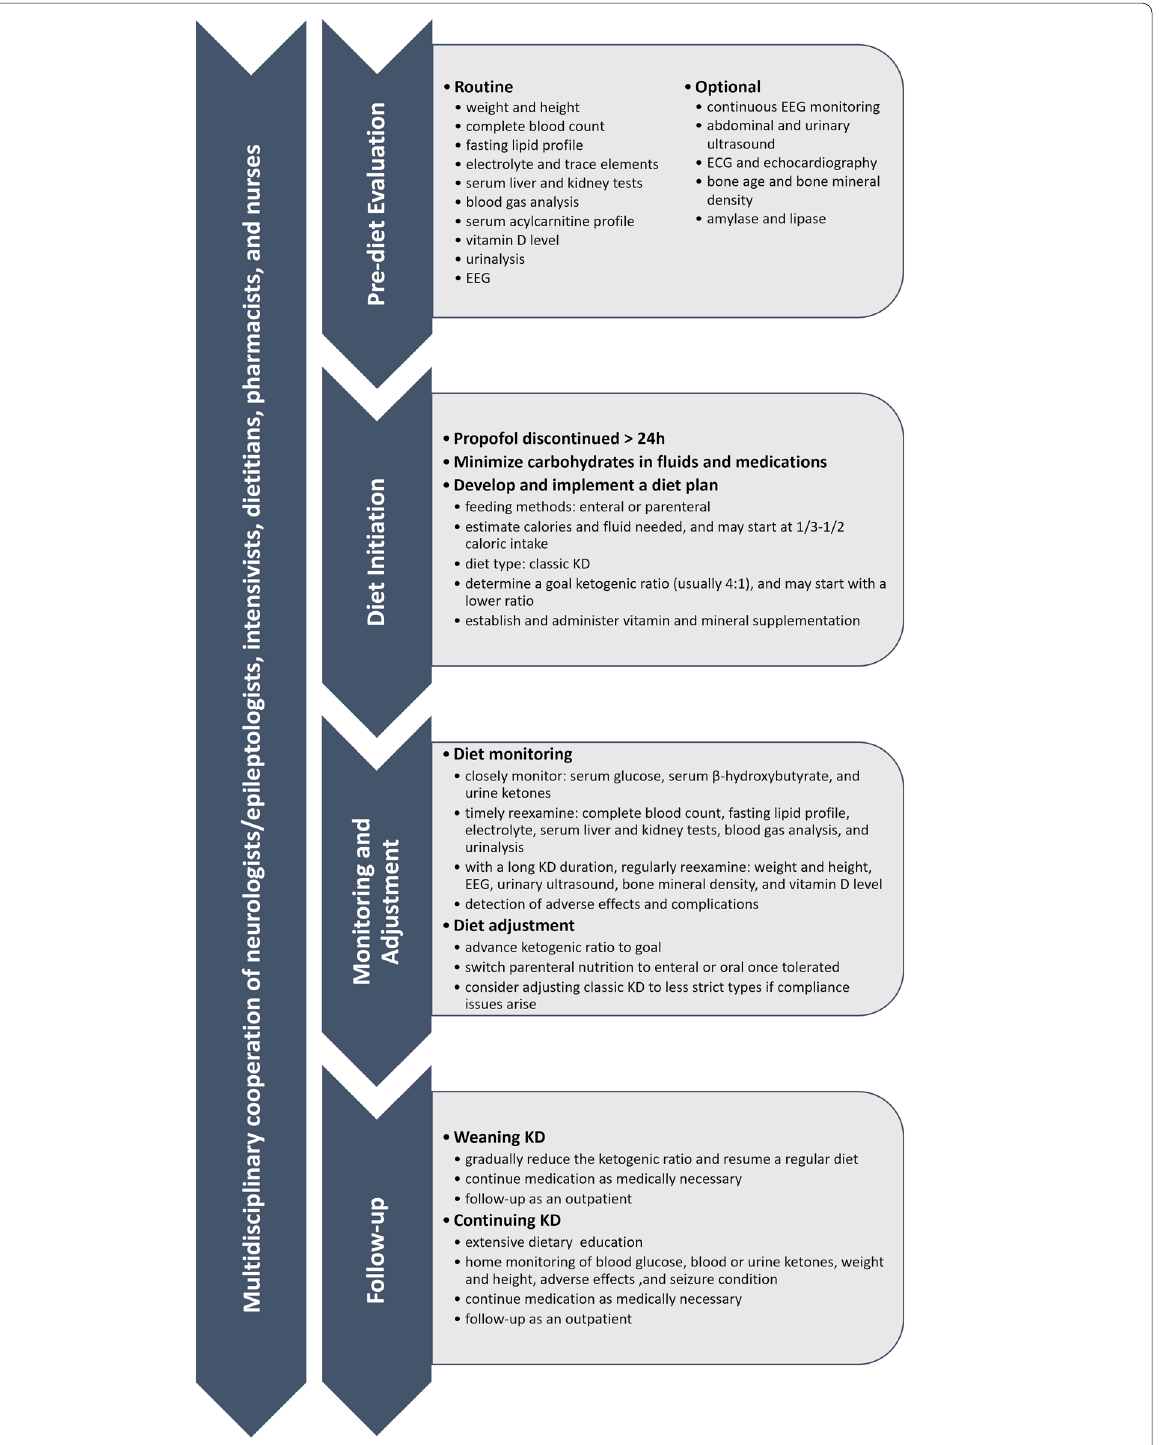
Fig. 1 The recommended implementation protocol of ketogenic diet for super-refractory status